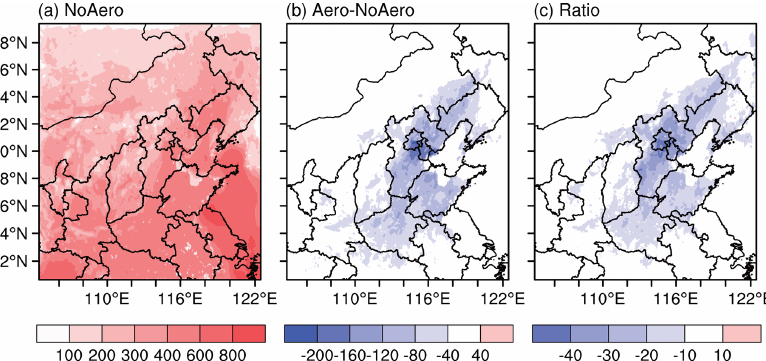
Figure 13. (a) Daytime mean PBLH (m) in NoAero, (b) the difference between Aero and NoAero (Aero minus NoAero) and (c) the ratio of changes (%) averaged during 6 to 10 December 2015.